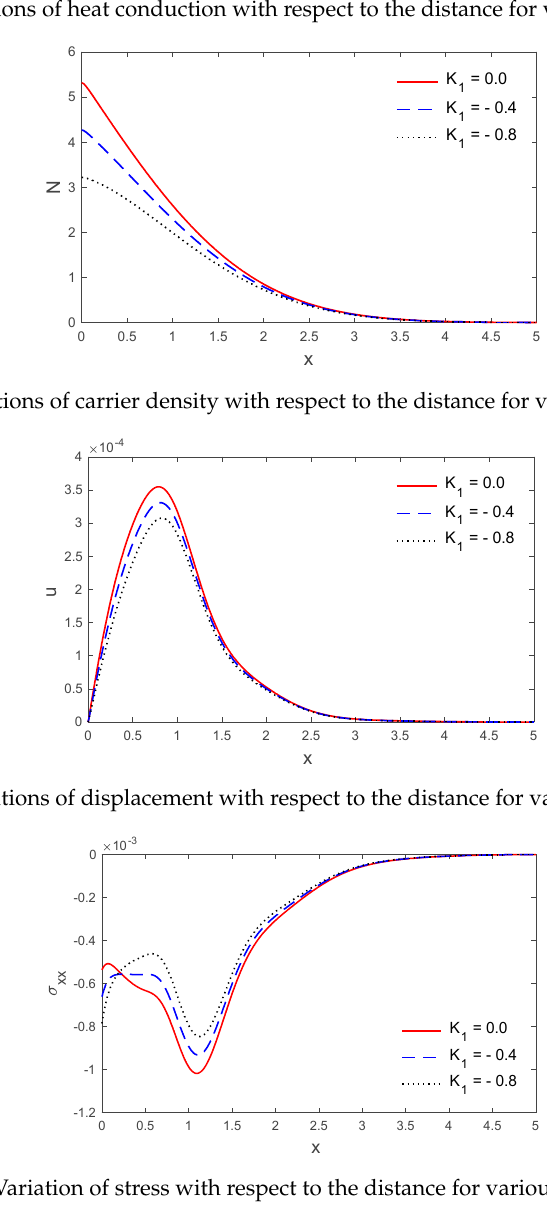
Figure 5. Variation of stress with respect to the distance for various values of K 1